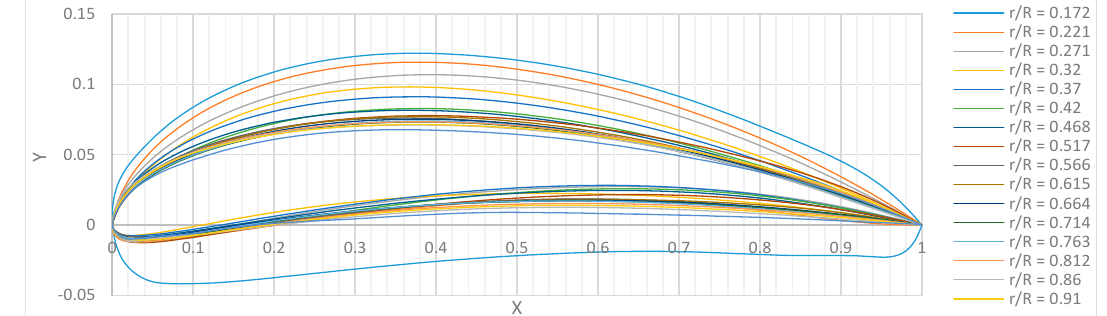
Figure 7. T-Motor 16 inch × 5.4 inch normalized 2D airfoil profiles.